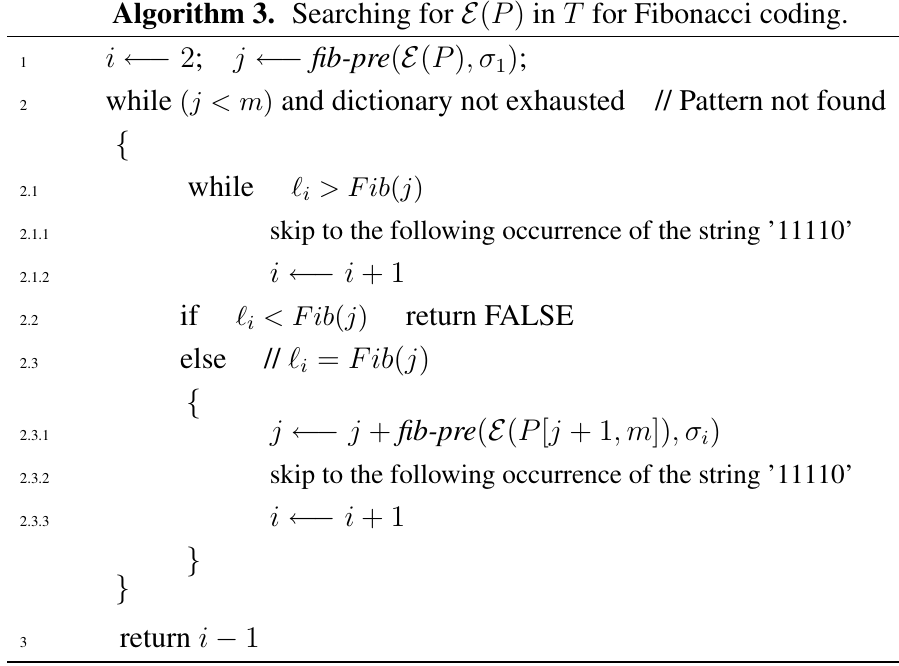
Algorithm 3. Searching for E ( P ) in T for Fibonacci